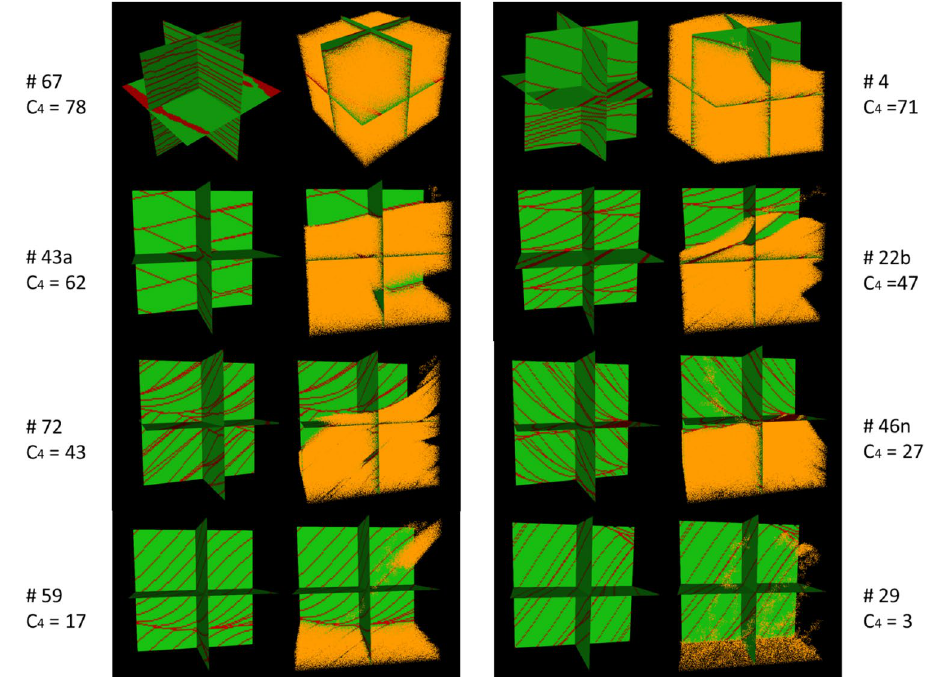
Figure 6. Bedform architecture and CO 2 saturation distribution for eight selected BAMs. Green: matrix; red: laminae; orange: CO 2 invaded cells with saturation 1 − S wc . The CO 2 saturation distribution is taken from a single simulation run with high grain size contrast values. The value of the fitted parameter C 4 for each BAM is also displayed.